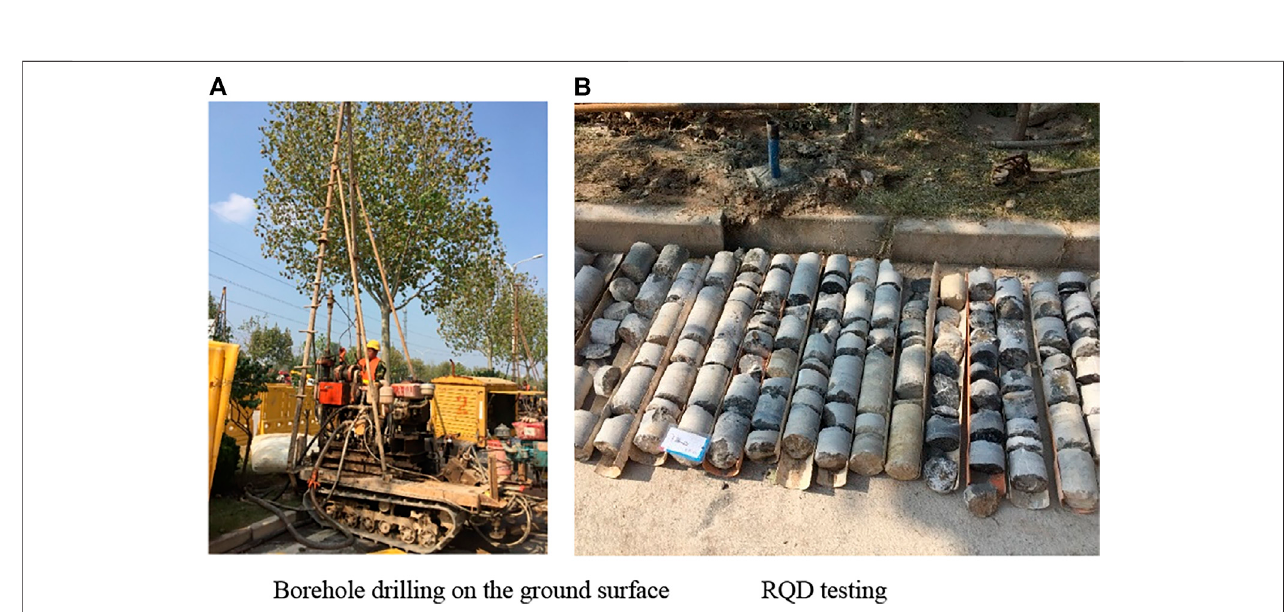
FIGURE 9 | Borehole drilling for karst and fractures detection. (A) Borehole drilling on the ground surface. (B) RQD testing.